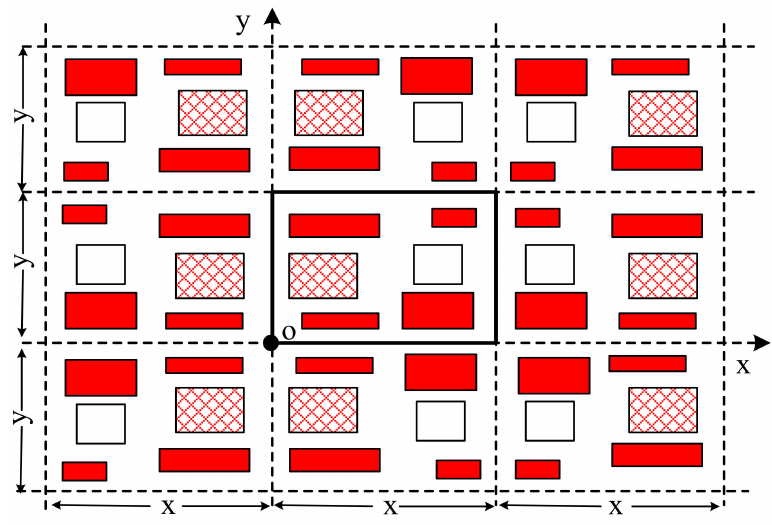
Figure 4. The double periodicity of current